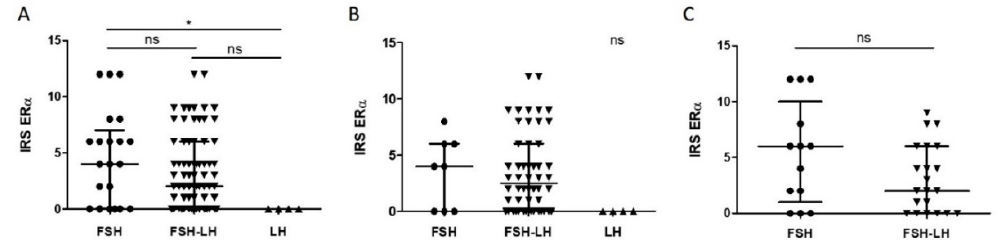
Figure 3. Tumor subtype-related comparison of IRS ER α distribution in all ( A ), male ( B ) and female ( C ) cases. Graphs: median with interquartile range. ( A ). Statistical test: Kruskal–Wallis, p = 0.02, n = 21, 73, 4, with Dunn’s test for columns comparison. ( B ). Statistical test: Kruskal–Wallis, p = 0.057, n = 8, 52, 4. ( C ). Statistical test: Mann–Whitney, p = 0.19, n = 13, 21. Abbreviations: immunoreactive score (IRS), estrogen receptor alpha (ER α ), follicle-stimulating hormone (FSH), luteinizing hormone (LH), not significant (ns), p < 0.05 (*).